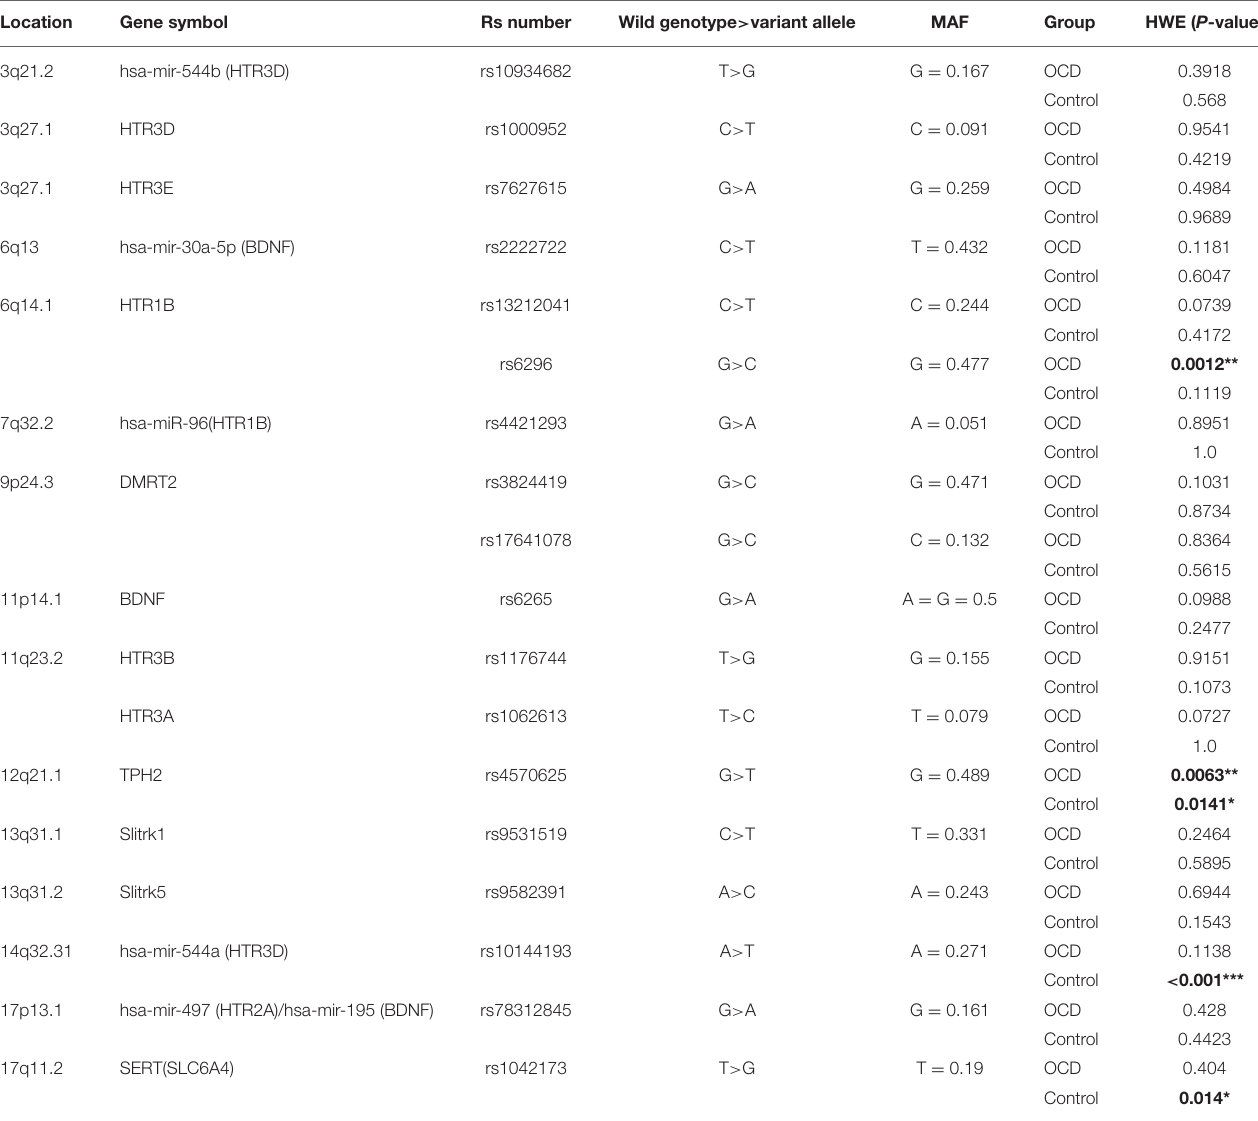
TABLE 2 | Characteristics of candidate genes and SNPs.